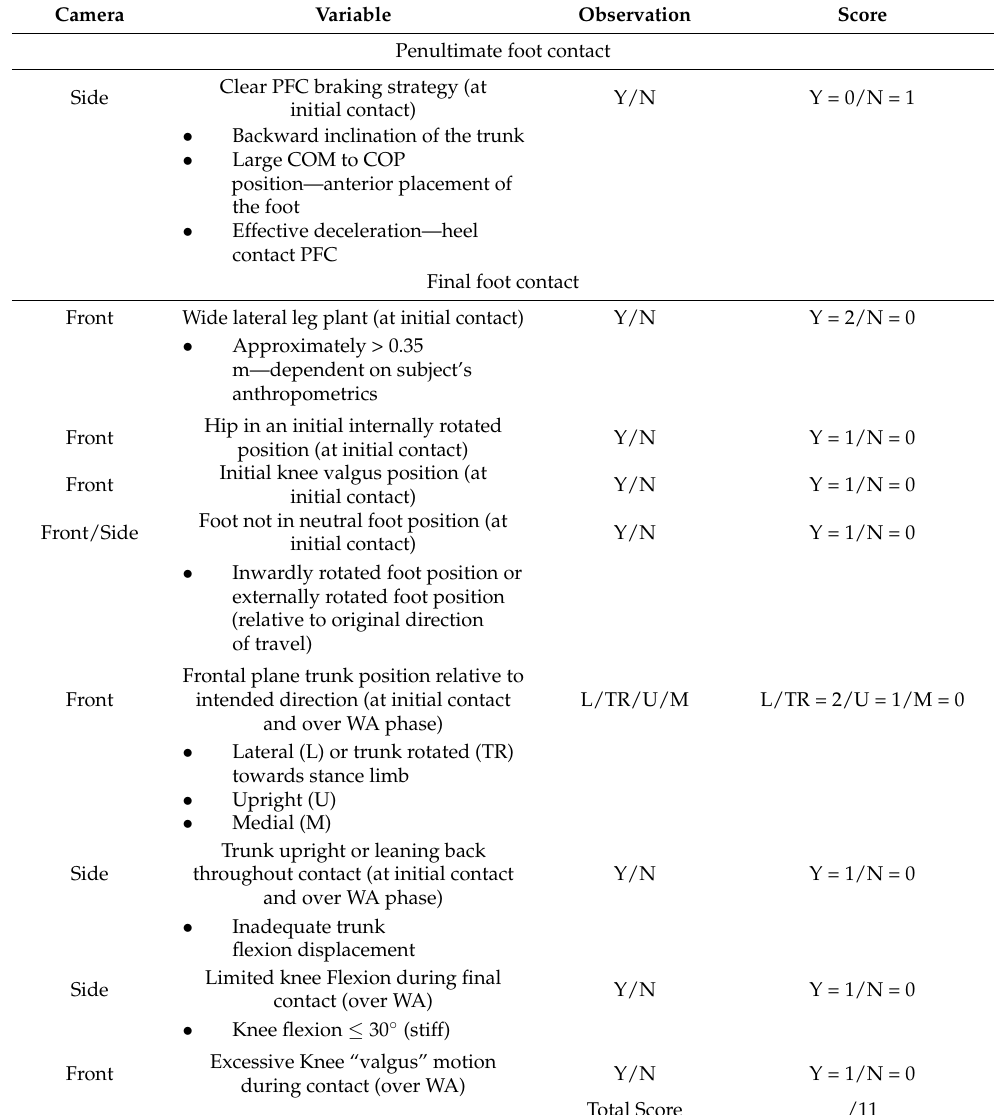
Table 1. Cutting Movement Assessment Score